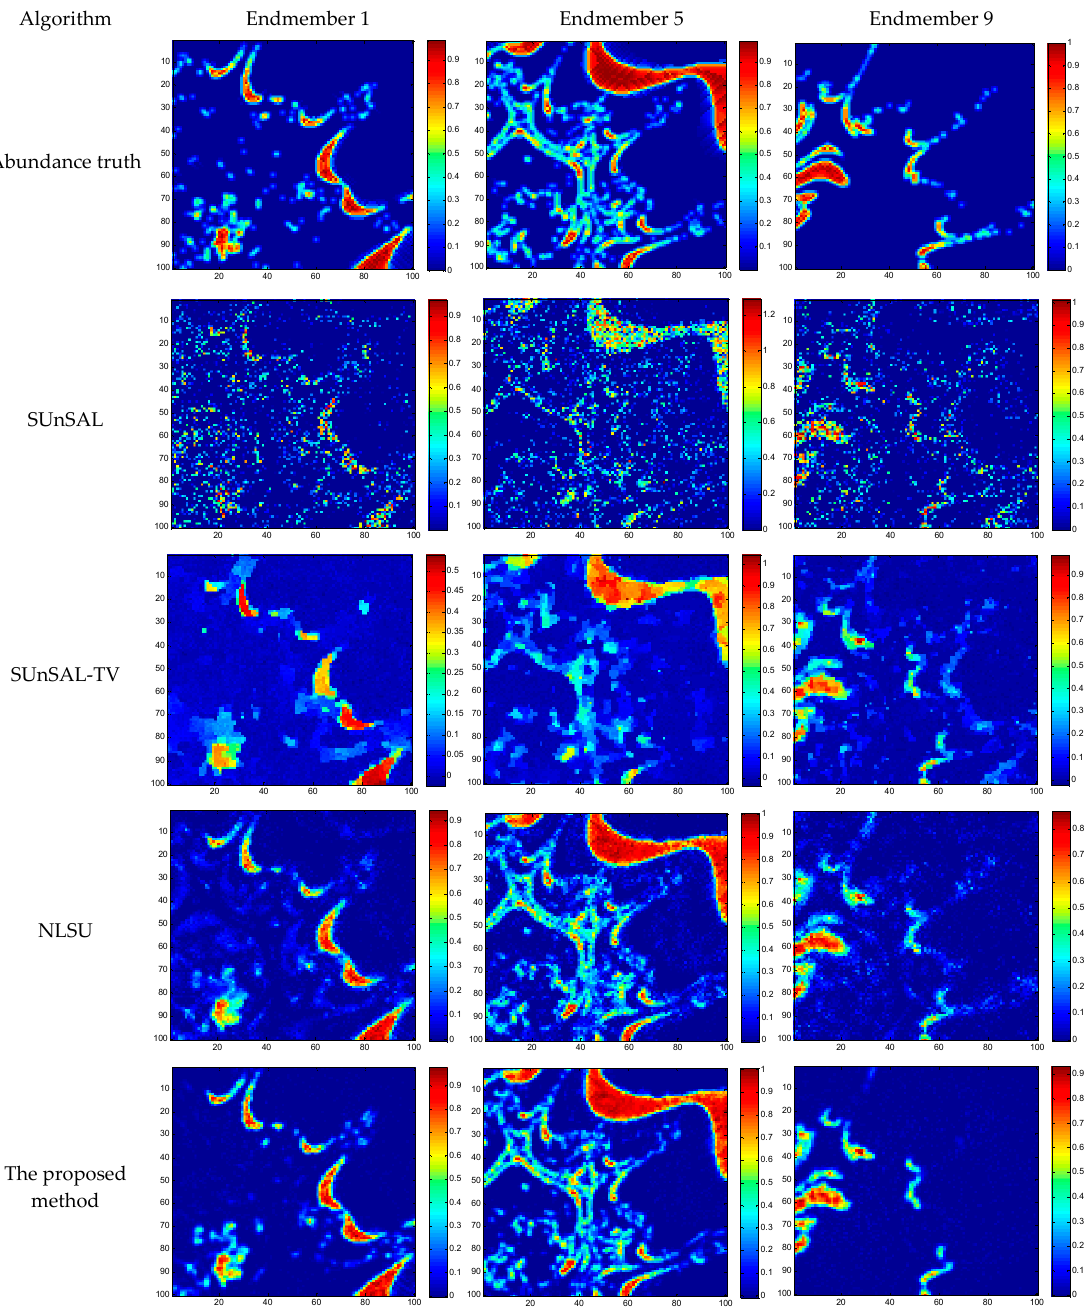
Figure 8. Estimated abundances of the endmembers for DC-3.